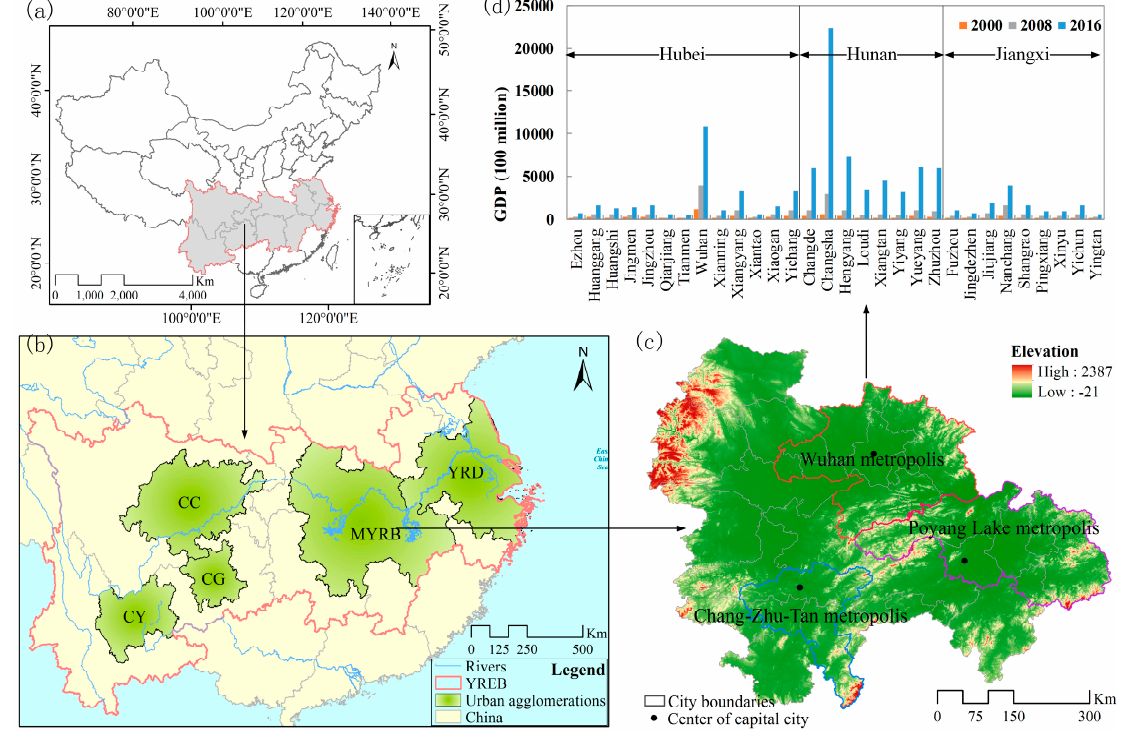
Figure 1. The location of the study area: ( a ) the study area in China; ( b ) the study area in the YREB area; ( c ) topography of the study area; and ( d ) total GDP of the prefectural cities in the MYRB urban agglomeration in 2000, 2008 and 2016. (CC: Chengdu-Chongqing Urban Agglomeration; CY: Urban Agglomeration in the central Yunnan, China; CG: Urban Agglomeration in central Guizhou, China.).